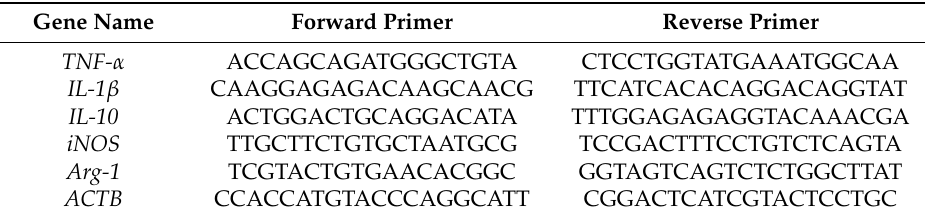
Table 2. Sequences of primers used for